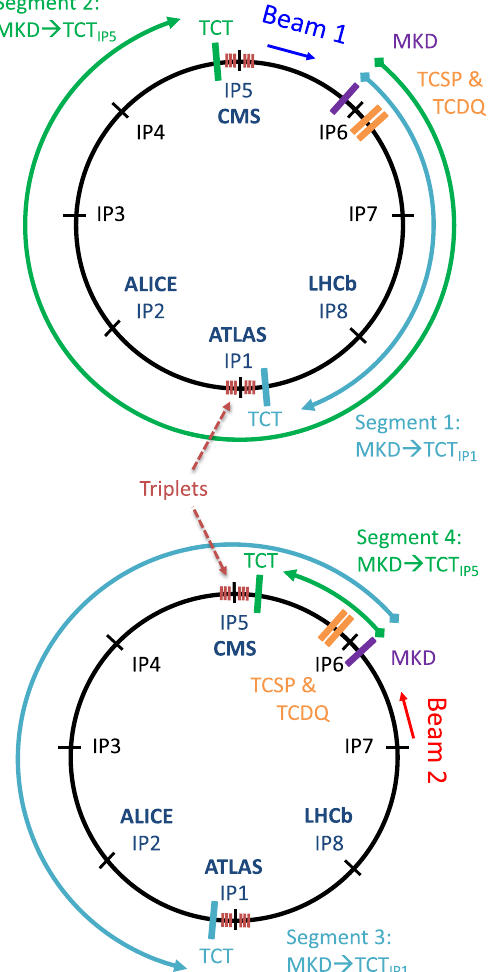
FIG. 1. Schematic view of the LHC layout highlighting only a subset of relevant beam-line elements. Both LHC beams circulate mostly through the same magnetic lattice in separated beam pipes. The layout for both beams is split in this figure in order to show the different positions of the dump kickers and protection elements (TCDQ, TCSP, and TCTs) together with the four beamline segments used for the tolerance generation (see Sec. IV B 2). Beam 1 (top) and Beam 2 (bottom).